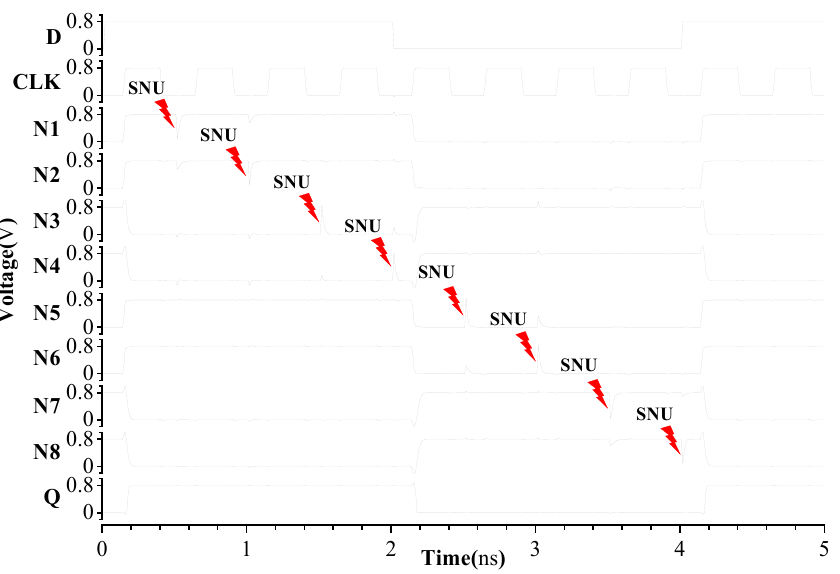
Figure 10. Simulation waveforms for DNURF considering SNU on key single nodes N1 to N8.